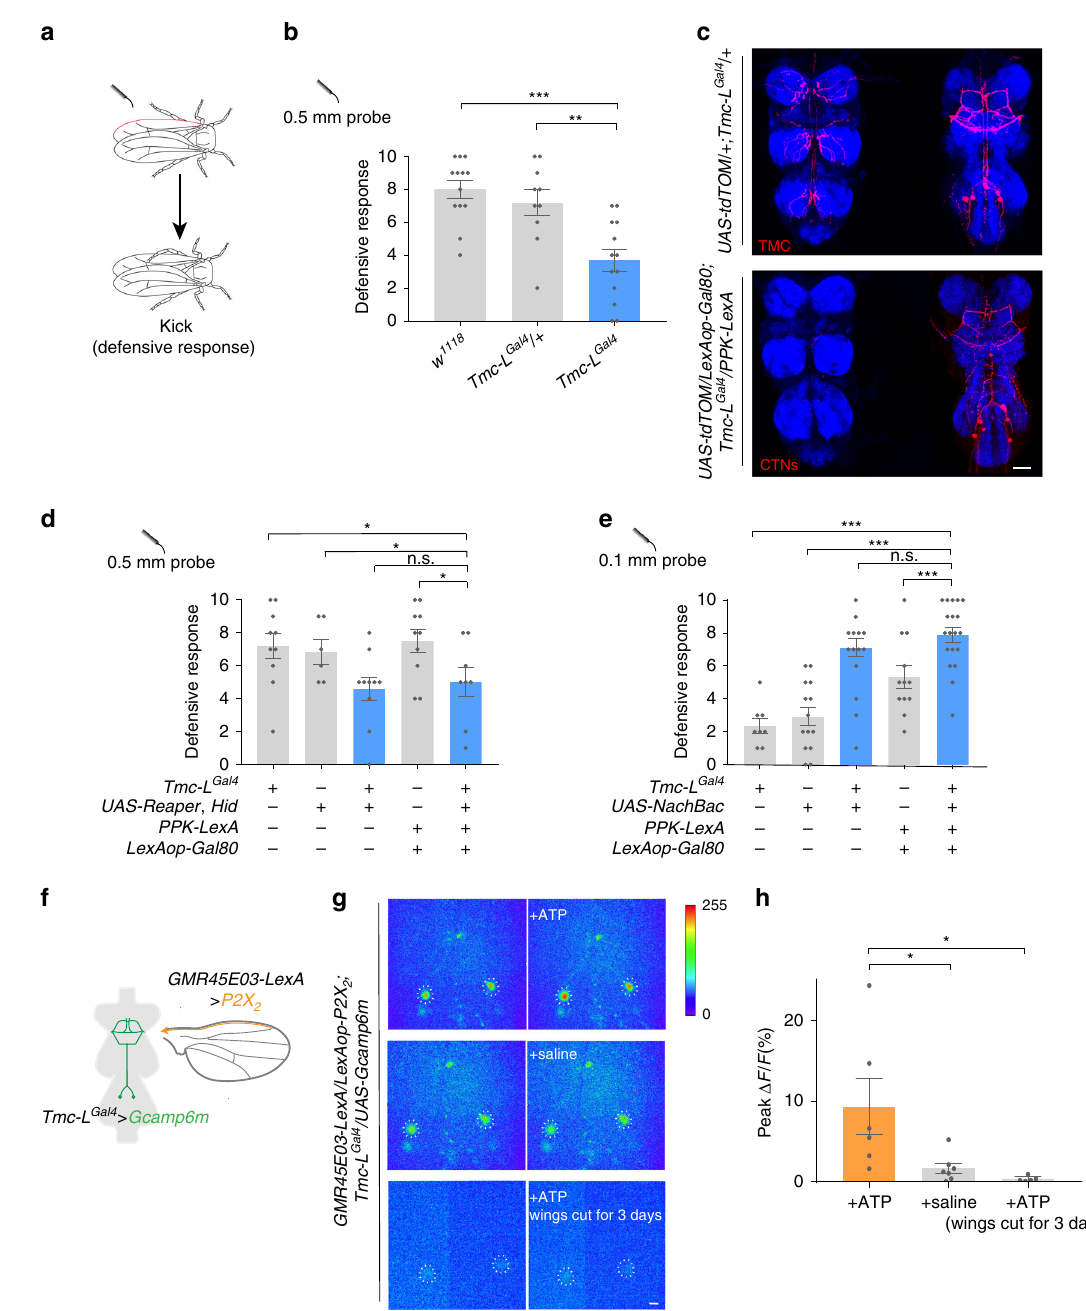
Fig. 1 Central Tmc-L neurons (CTNs) mediate defensive response to mechanical stimuli on the wing margin. a Schematic of the defensive response assay. A probe was used to challenge the mechanosensory bristles on the wing margin (marked with red) of decapitated fl ies. b Defensive response score of w 1118 , Tmc-L Gal4 / + , and Tmc-L Gal4 stimulated 10 times by a 0.5 mm probe. n = 13, 10, and 13 for each group. ** p < 0.01 and *** p < 0.001, two-tailed unpaired t tests. c Expression pattern of Tmc-L Gal4 (red) in the ventral and dorsal sides of VNC. Lower panel: PPK-LexA > lexAop-Gal80 inhibited peripheral projections of Tmc-L neurons to the ventral VNC. Blue: nc82. Scale bar represented 50 μ m. d Ablating all Tmc-L neurons or only CTNs with Reaper and Hid. n = 10, 6, 10, 10, and 8 for each group. * p < 0.05, p > 0.05 (n.s.), two-tailed unpaired t tests. e Activating all Tmc-L neuron or only CTNs with NachBac. n = 8, 14, 18, 12, and 19 for each group. *** p < 0.001, p > 0.05 (n.s.), two-tailed unpaired t tests. f Schematic of the Ca 2 + imaging assay of ( g ). g Calcium response of CTNs ’ cell bodies in the VNC before (left) and after (right) application of ATP or saline. Cell bodies of CTNs were cycled with white dashed circles. Scale bar represented 50 μ m. h Peak fl uorescence changes ( Δ F / F ) of CTNs ’ cell bodies after ATP application ( n = 6), saline application ( n = 7) and ATP application to VNC from fl ies whose wings had ablated for 3 days ( n = 5). * p < 0.05, two-tailed unpaired t tests. Error bars indicate mean ± SEM, n.s., not signi fi cant. Source data are provided as a Source Data fi consistence. These results support the notion that CTNs integrate detectable Ca 2 + responses in the genetic control animals (Sup- mechanosensory input from the periphery for the control of plementary Fig. 1e). The fl uorescence of heterozygous Tmc-L defensive actions, although an explant may not completely re fl ect driver expressed GCamp6m was too weak to resolve all the 4 – 6 the response to wing touch in intact fl ies. neurons, thus we quanti fi ed the two super fi cial neurons for